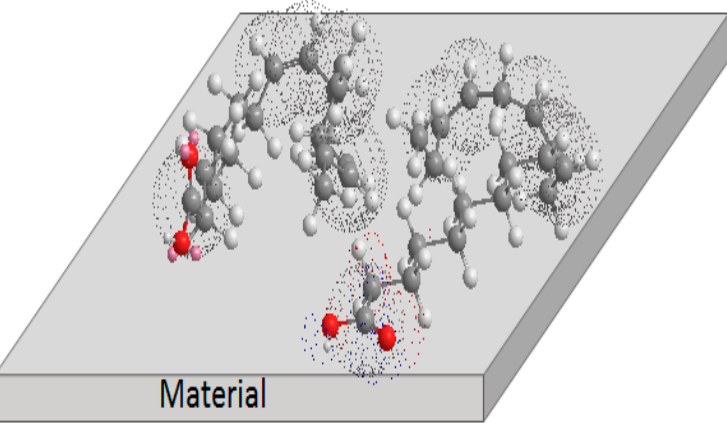
α -linolenic acid on steel